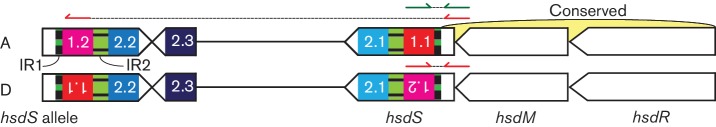
The structure of the ivr type I restriction-modification locus in S.
pneumoniae. The restriction (hsdR) and methylation (hsdM) subunits, and the 5′ end of the specificity subunit (hsdS) are generally conserved. Inverted repeats IR1 (85 bp) and IR2 (333 bp) facilitate switching of downstream incomplete hsdS elements into the transcribed region. Top: the green read pair has the expected insert size, and suggests allele A (1.1, 2.1) is present; the red read pair is in the wrong orientation and has an anomalously large insert size. Bottom: the red read pair is consistent with the displayed inversion, suggesting allele D (1.2, 2.1) is present.